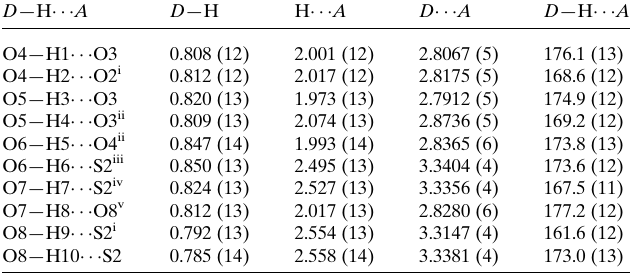
Table 1 Hydrogen-bond geometry (A˚ , (cid:3) ) for Na 2 S 2 O 3 (cid:2) 2H 2 O at 100 K. D —H (cid:2)(cid:2)(cid:2) A